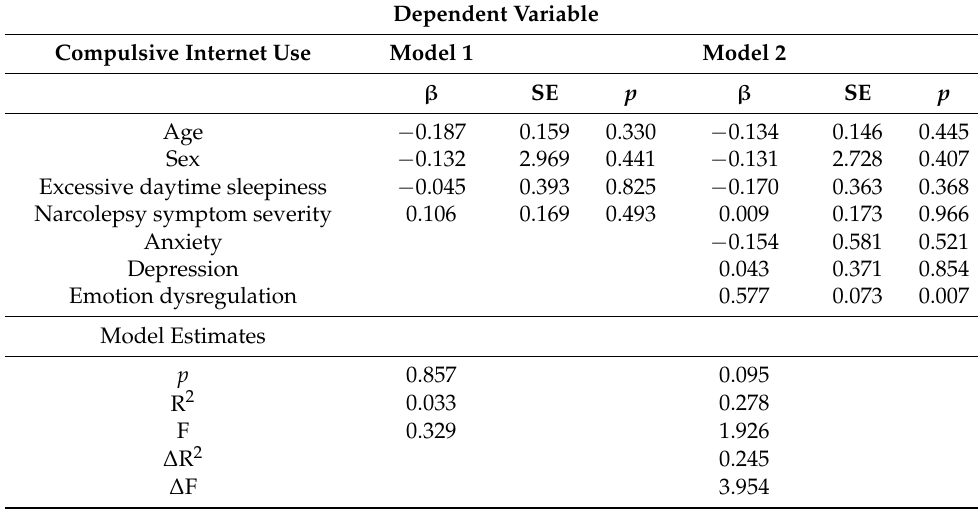
Table 3. Hierarchical multiple regression predicting compulsive Internet use levels.